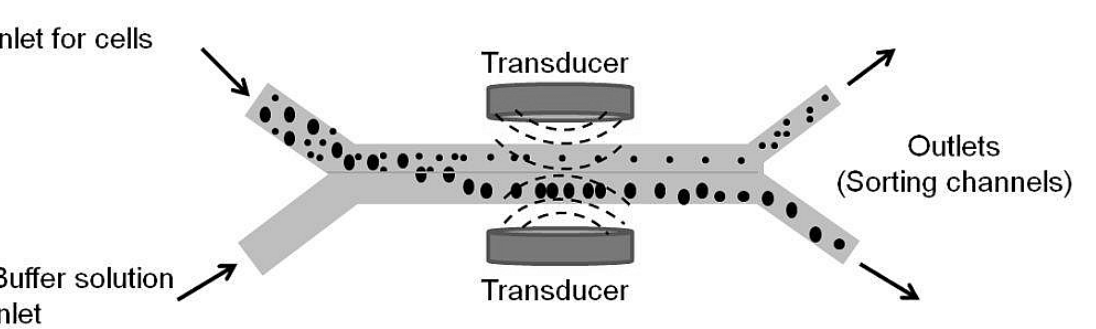
Figure 6. Schematic view of a device for particle size sorting. Suspended particles from a solvent such as blood cells from plasma are sorted using two parallel transducers close to the main channel to produce a field of the ultrasonic standing wave. The particles in the solution, affected by the ultrasonic standing waves, are directed to one side of the channel while the diluted solution flows via the central channel to the